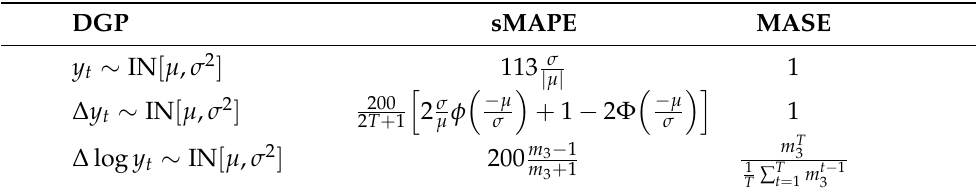
Table 2. Approximate expectations of sMAPE and MASE under different data generation processes, H = 1. Φ is the standard normal cdf, φ the density, m 3 = exp ( µ + σ 2 /2 ) .